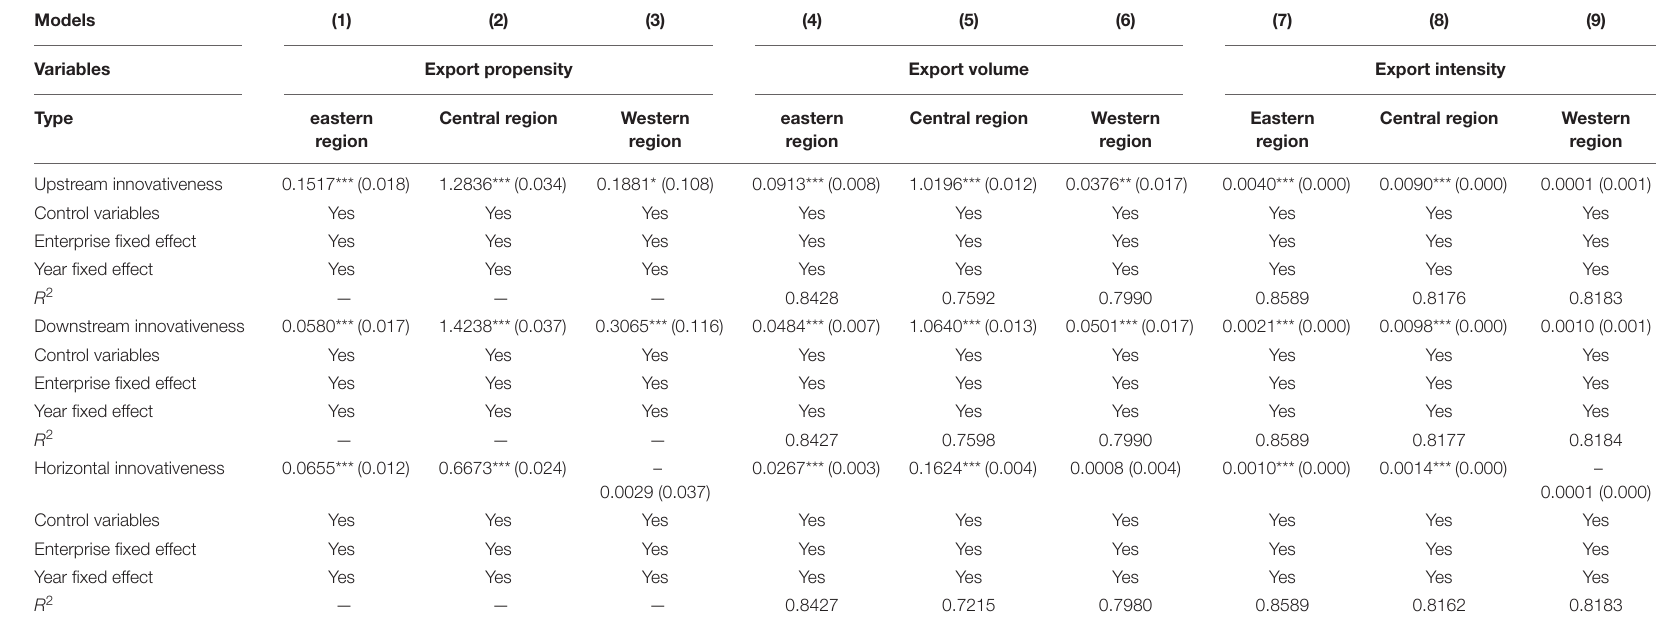
TABLE 4 | Heterogeneity analysis by